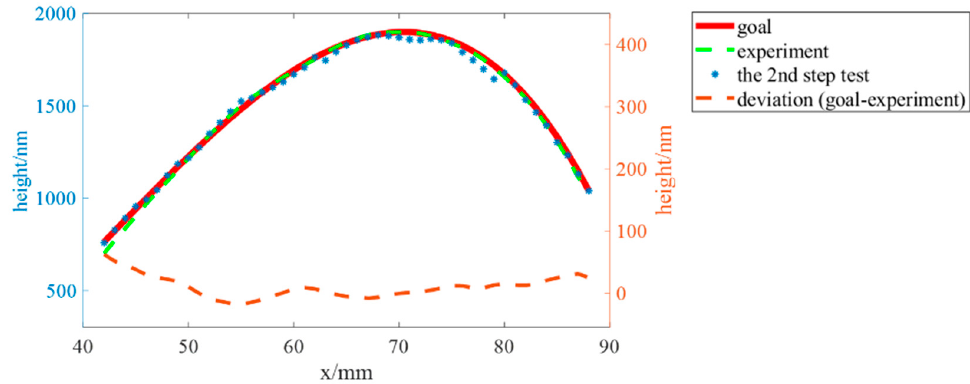
Figure 19. Radial film thickness